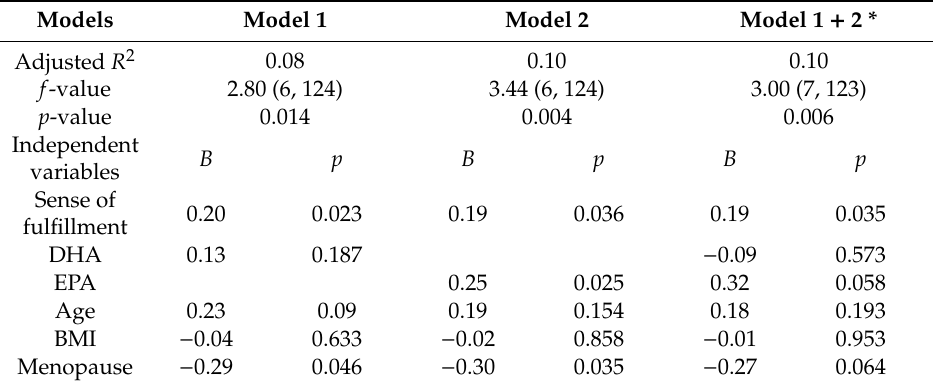
Table 3. Regression models used to explain